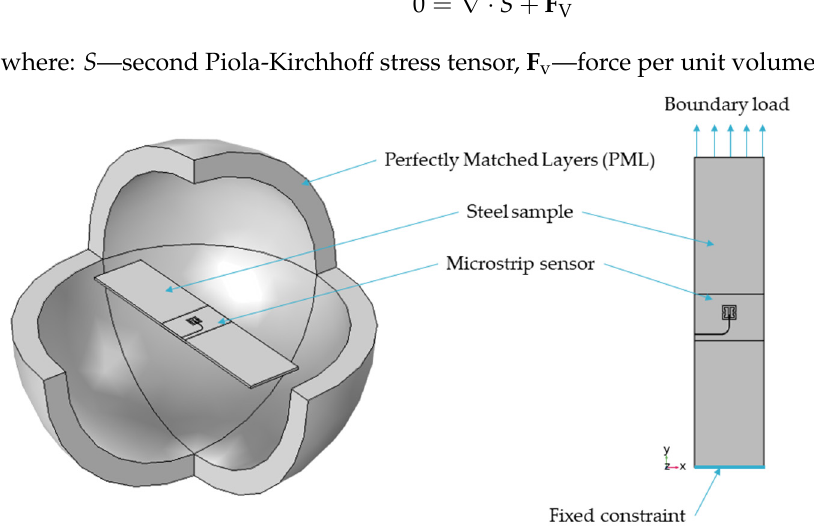
Figure 2. Finite Element Method model with a dSRR sensor attached to the steel sample. Mechanical loading of the sample simultaneously deforms the tested microstrip